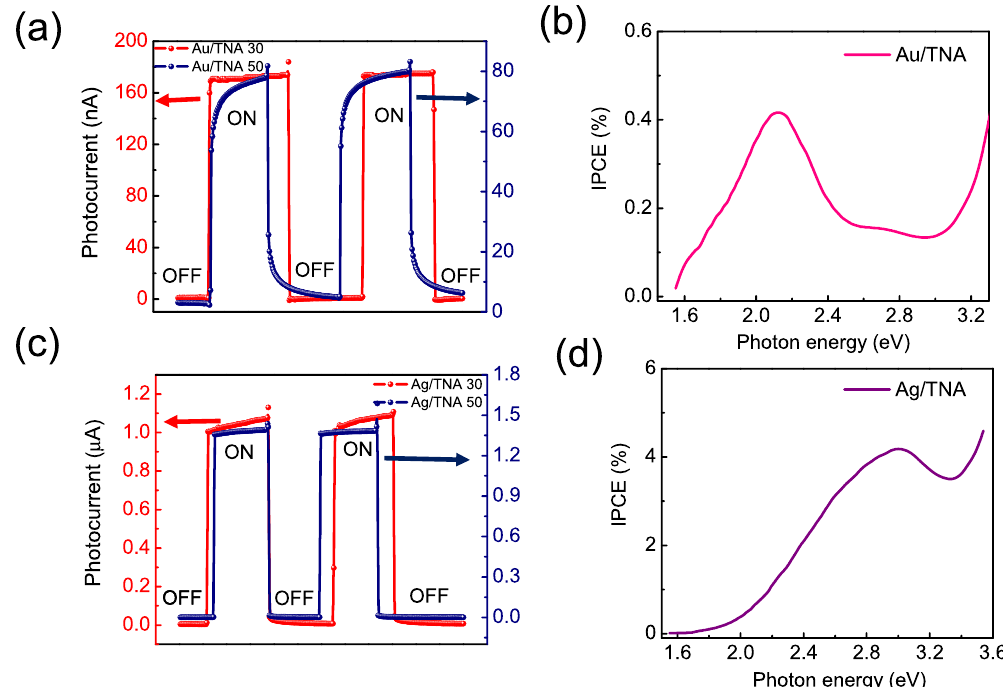
Figure 3. ( a ) Photocurrent measurements of the Au/TNA 30 and Au/TNA 50 nanodiodes by exciting the diode with a light source during a period of on/off conditions. ( b ) Incident photon to current conversion efficiency (IPCE) measurements as a function of photon energy for the Au/TNA with the peak observed at 584 nm (2.12 eV) corresponding to the surface plasmonic peak of the active Au thin layer on TiO 2 . ( c ) Photocurrent measurements of the Ag/TNA nanodiodes. The Ag/TNA 30 nanodiode has a photocurrent of 1.1 µ A and the photocurrent for the Ag/TNA 50 nanodiode is around 1.4 µ A. ( d ) IPCE measurements as a function of photon energy for the Ag/TNA with the peak observed at 414 nm (2.99 eV) corresponding to the surface plasmonic peak of the active Ag thin layer onTiO 2